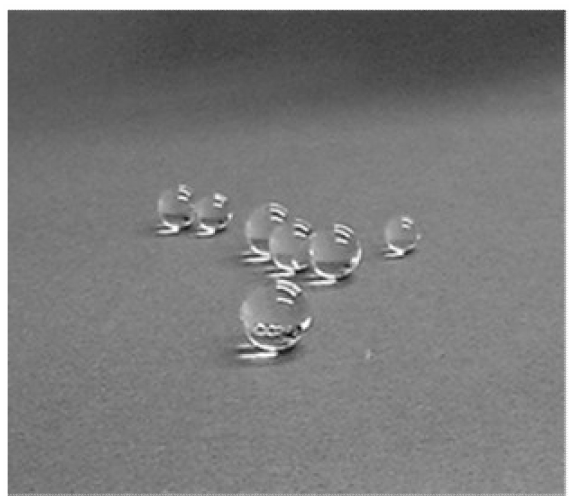
Figure 3. Large poly(benzyl methacrylate) spheres fabricated by levitation polymerization. The size of the sphere is 7 to 9 mm in